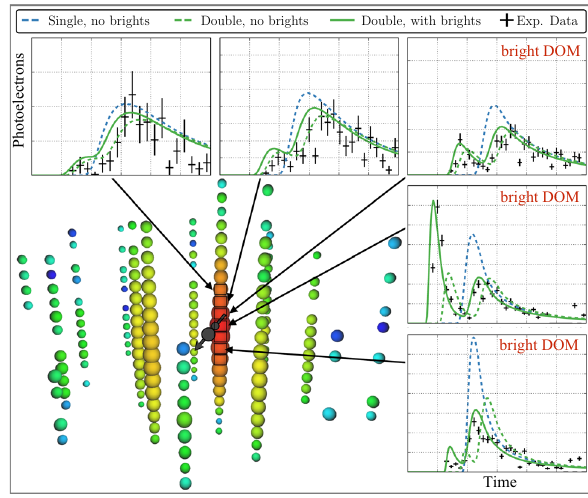
Fig. 4 Double-cascade event #2 (2014). The reconstructed double- cascade vertex positions are indicated as grey circles, the direction indi- cated with a grey arrow. The size of the circles illustrates the relative deposited energy, the color encodes relative time (from red to blue).